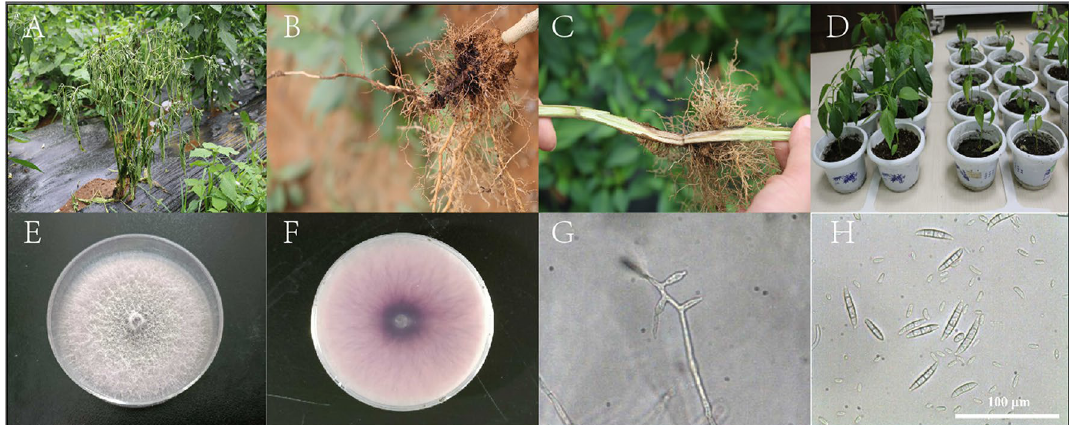
Figure 1. Typical symptoms and identification of pathogen strains of pepper Fusarium wilt in experimental sites. ( A ) At the late stage of Fusarium wilt, the whole plant withered and died; ( B ) the lateral root and taproot of the pepper turn brown and rot; ( C ) discoloration of vascular bundle in pepper stem after cutting; ( D ) after the isolated F. oxysporum was inoculated on the pepper, which showed the initial symptoms of wilt disease; ( E ) positive characteristics of F. oxysporum colony; ( F ) negative characteristics of colony; ( G ) sporulation peduncle in bottle shape; ( H ) large and small conidia.